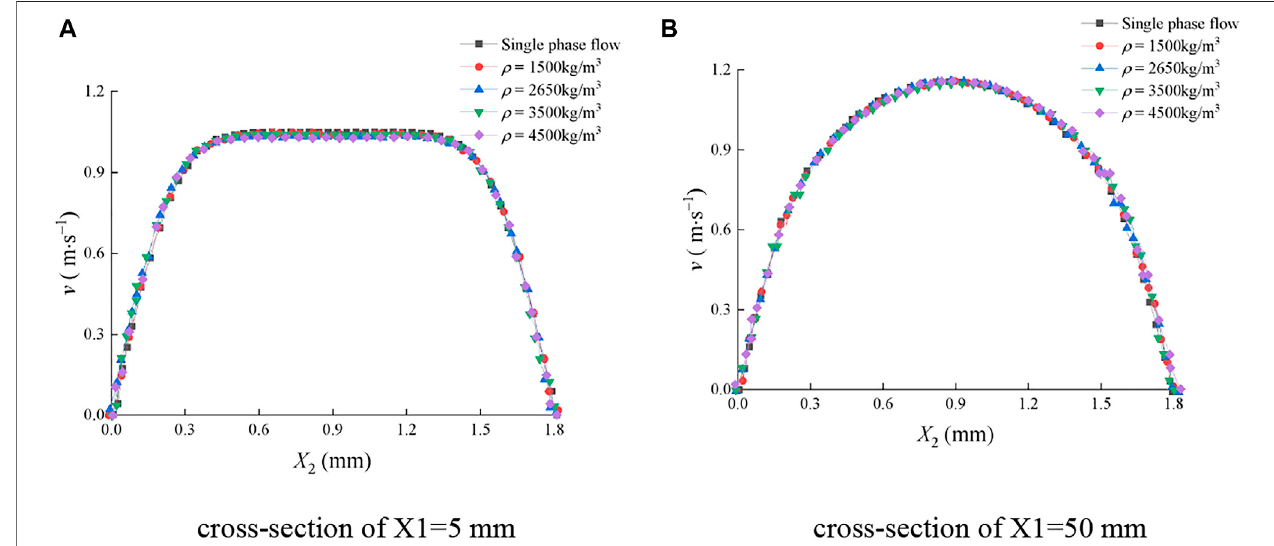
FIGURE11| Meanvelocitydistributionofthecontinuous-phase fl uidonthecrosssectionsofthesmoothfractureunderdifferentsedimentparticlemassdensities. (A) Cross section of X1=5 mm; (B) cross section of X1=50 mm.